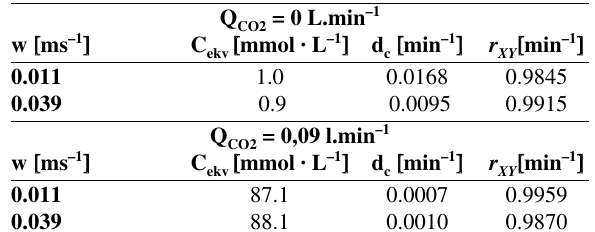
Table 5. Kinetic parameters and correlation coefficients; (w = 0.09 L.min –1 ) L.min –1 and w CO2